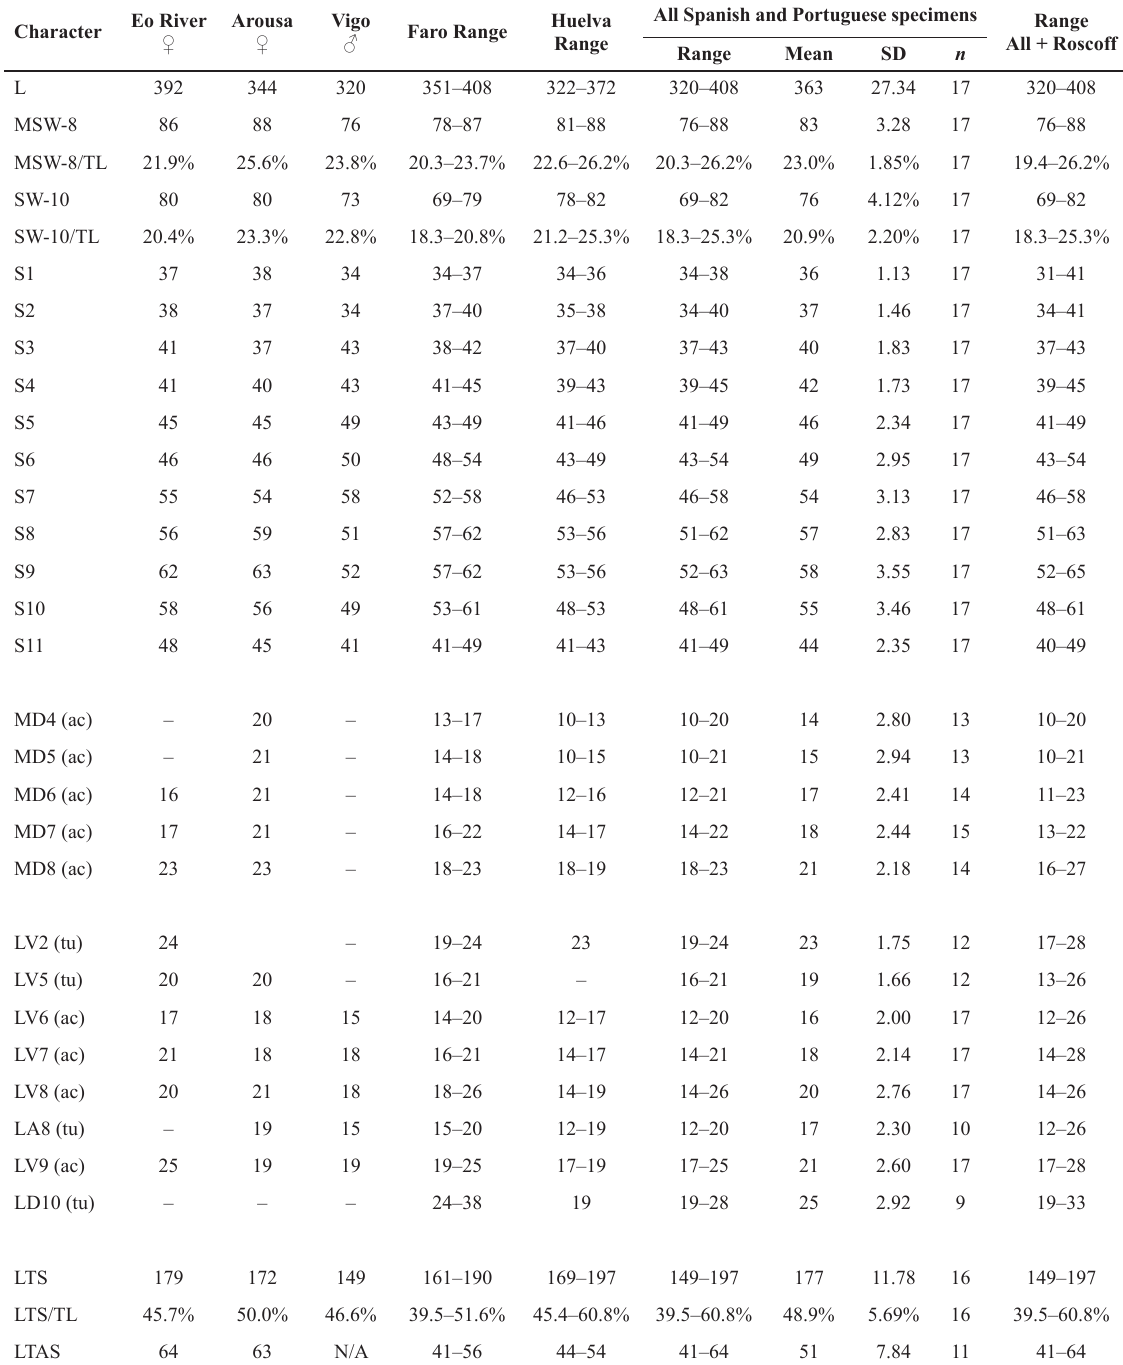
Table 3. Measurements from light microscopy for specimens of Echinoderes dujardinii Claparède, 1863 from various localities along the Atlantic coasts of Spain and Portugal (in µm), including number of measured specimens ( n ) and standard deviation (SD). Right column (Range All + Roscoff) shows ranges of Spanish and Portuguese populations merged with ranges from the French Roscoff population examined by Higgins